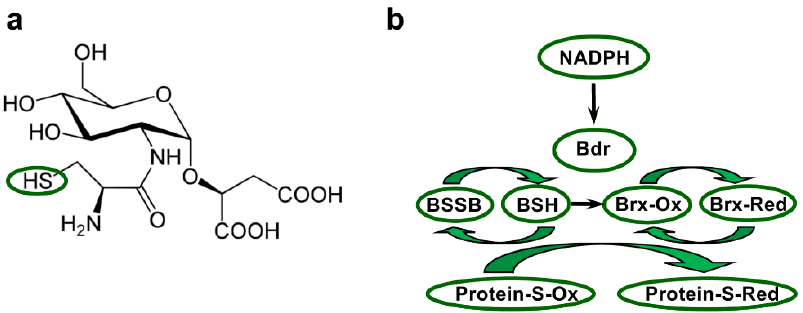
Figure 4. The bacillithiol system. ( a ) Structure of bacillithiol (BSH), glycoside formed of L-cysteinyl- D-glucosamine and malic acid. ( b ) Electron transfer pathways in the BSH system. Bdr, NADPH– bacillithiol disulfide reductase. Brx, bacilliredoxin; S-Ox, thiol oxidised (bacillithiolated) form; S-Red, thiol reduced form.